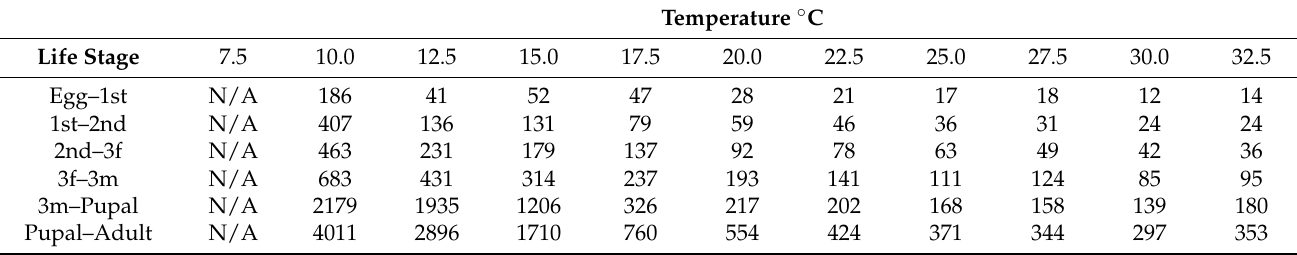
Table 3. Mean time (hours) for Lucilia sericata to reach 50% of the population for each life stage and